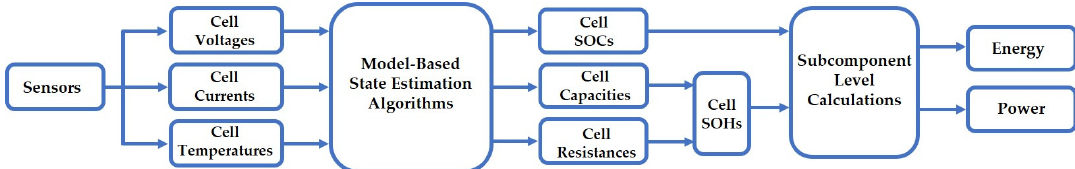
Figure 1. Execution flow diagram of parameter estimation algorithms involved in battery management systems (BMS) [1].